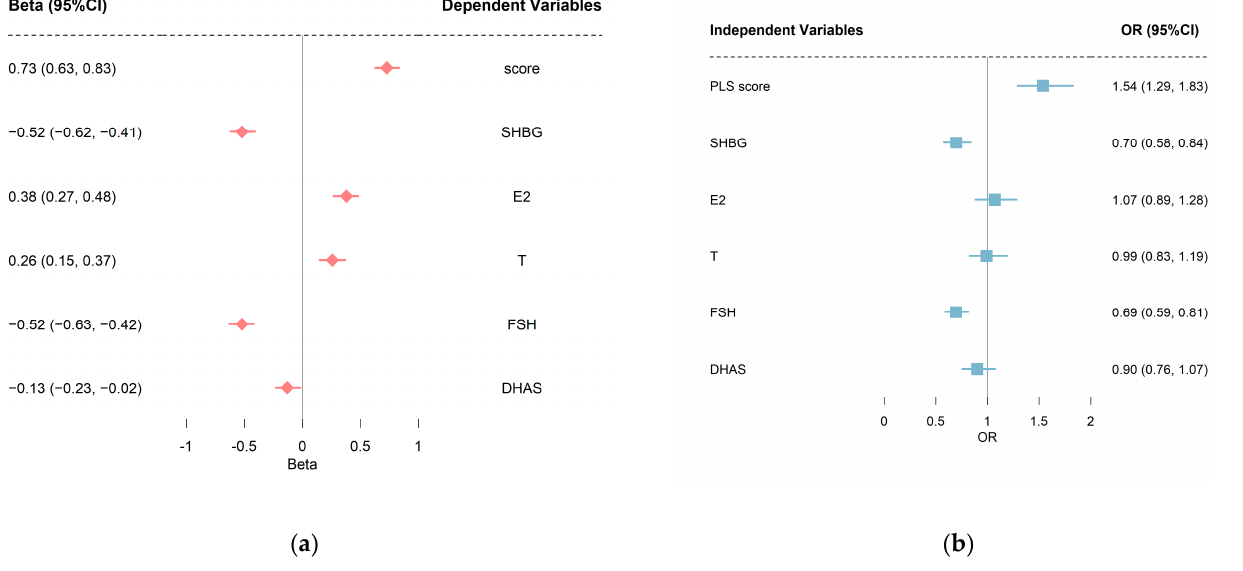
Figure 2. ( a ) Standard regression coefficients and 95% CIs of overweight/obesity on sex hormones. ( b ) Standard OR coefficients and 95% CIs of sex hormones on hyperglycemia. Covariates adjusted in linear regression models were baseline age, race, smoking regularly, education, physical activities, and follow-up years. Covariates adjusted in logistic regression models were baseline age, race, smoking regularly, education, physical activities, follow-up years, and overweight/obesity. PLS, partial least squares; SHBG, sex hormone binding protein; E2, estradiol; T, testosterone; FSH, follicle-stimulating hormone; DHAS, Dehydroepiandrosterone